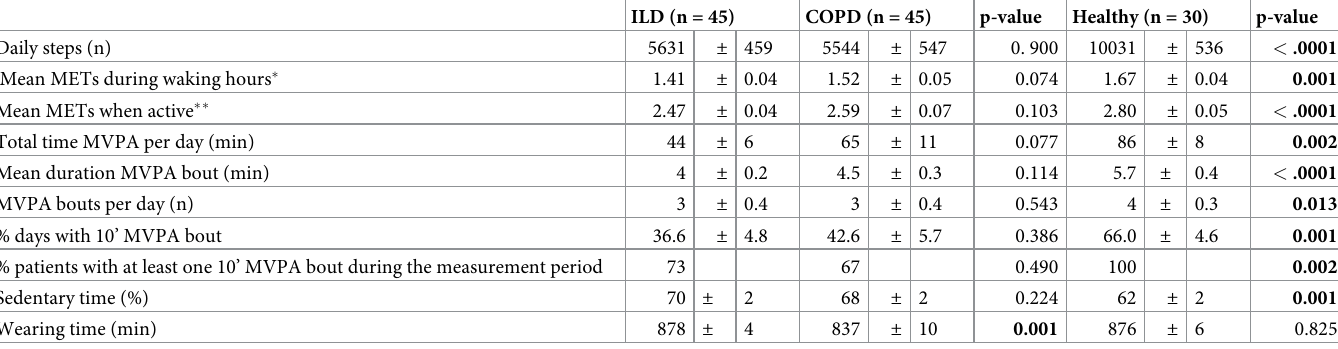
Table 3. Physical activity characteristics of patients with ILD, COPD and healthy